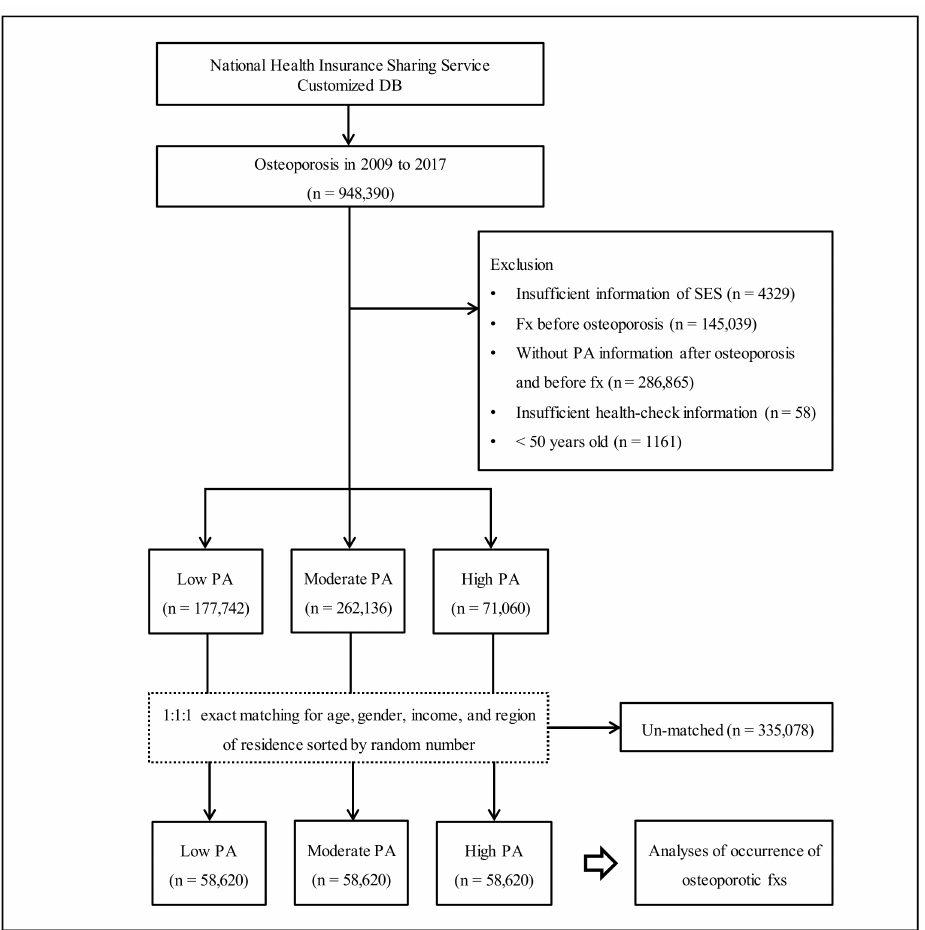
Figure 1. The participant selection flow. Out of a total of 948,390 participants with osteoporosis, ‘high PA’ ( n = 58,620), ‘moderate PA’ ( n = 58,620), and ‘low PA’ ( n = 58,620) were matched by a ratio of 1:1:1 by age, gender, income, and region of residence. Abbreviation: fxs, fractures; PA, physical activity; SES, socioeconomic